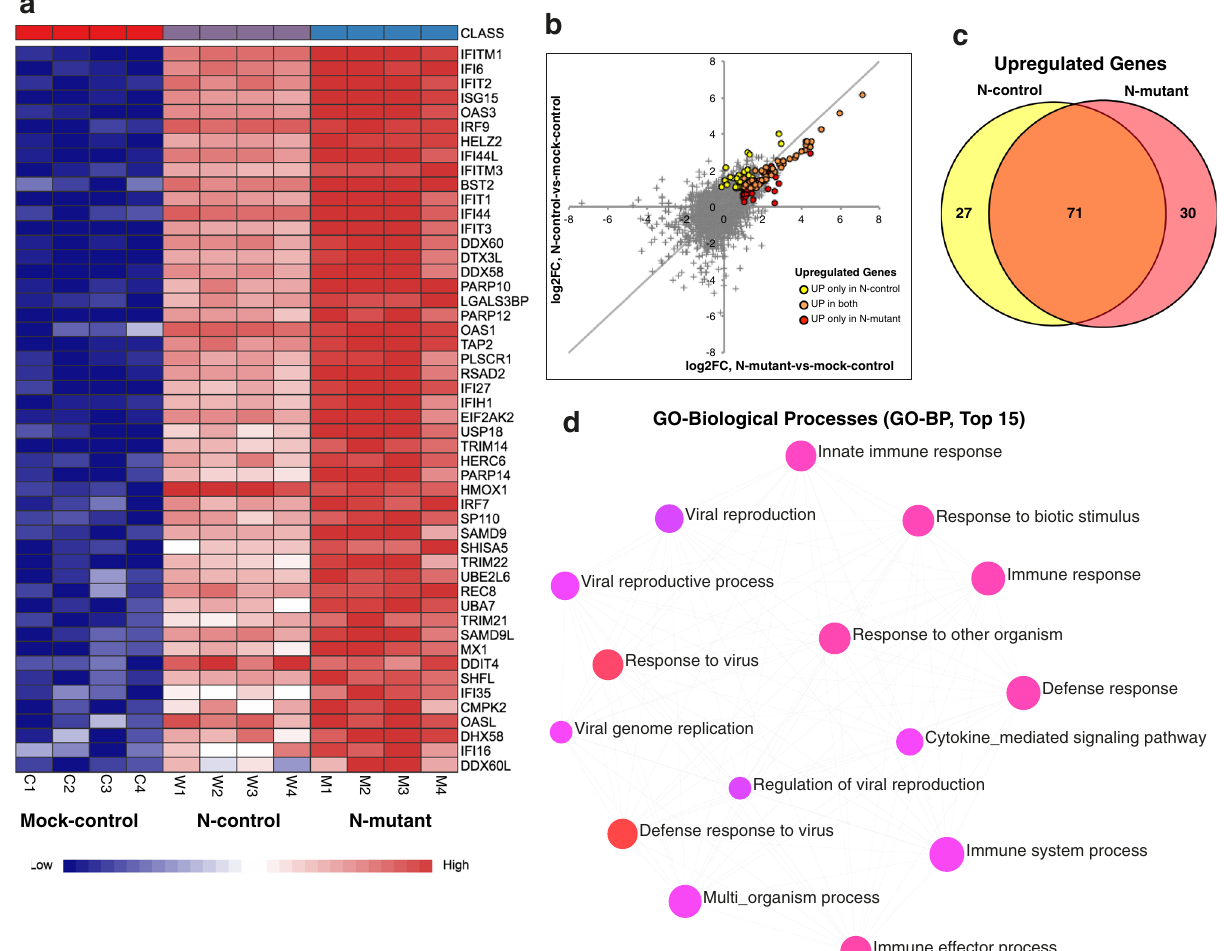
Fig. 5 Transcriptional pro fi ling of mutant and control N transfected cells. Calu-3 cells were transfected with plasmids expressing the full-length N-control and N-mutant protein along with mock control (4 biological replicates per condition). 48-h post-transfection total RNA was isolated and subjected to RNA- sequencing using illumina NovaSeq 6000 platform. a Heatmap shows normalized expression of top signi fi cantly differentially expressed genes in N-mutant and N-control conditions (adj p -value <0.05 and log2 fold-change cutoff ≥ 1). Genes enriched in interferon and immune-related processes are overexpressed in the N-mutant transfected cells. The heatmap was generated by the visualization module in the NetworkAnalyst. b Plot showing comparison of fold-changes for all DE genes in N-mutant and N-control conditions. Differentially expressed genes display higher up-regulation in the N-mutant condition (as orange dots that represent common up-regulated genes are skewed towards the lower half of the diagonal). c Venn diagram shows the common and unique up-regulated genes in both conditions. d GO-enrichment analysis (top 15 pathways based on p -value and FDR are shown) of up- regulated genes. The enriched GO BP (Biological Processes) term is related to defense and interferon response. The enriched terms display an interconnected network with overlapping gene sets (from the list). Each node represents an enriched term and colored by its p-value from red to blue in ascending order (red shows the smallest p -value) as shown in Supplementary Data 6. The size of each node corresponds to number of linked genes from the